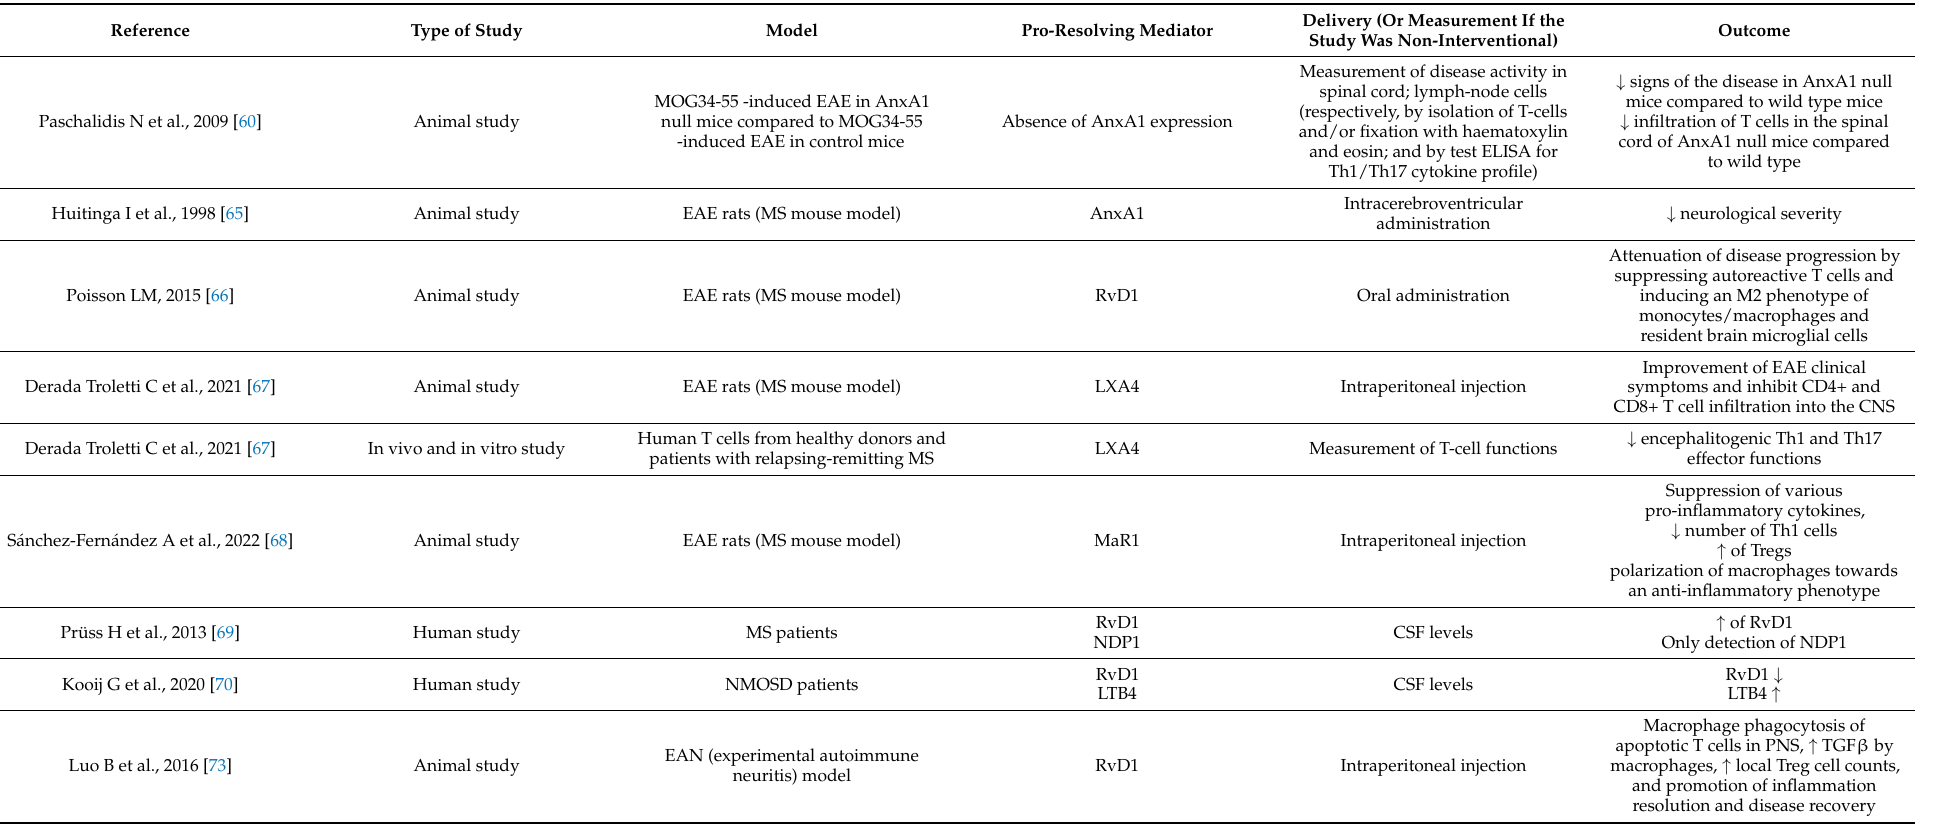
Table 2. Summary of in vivo studies on SPMs in neurological immune-mediated